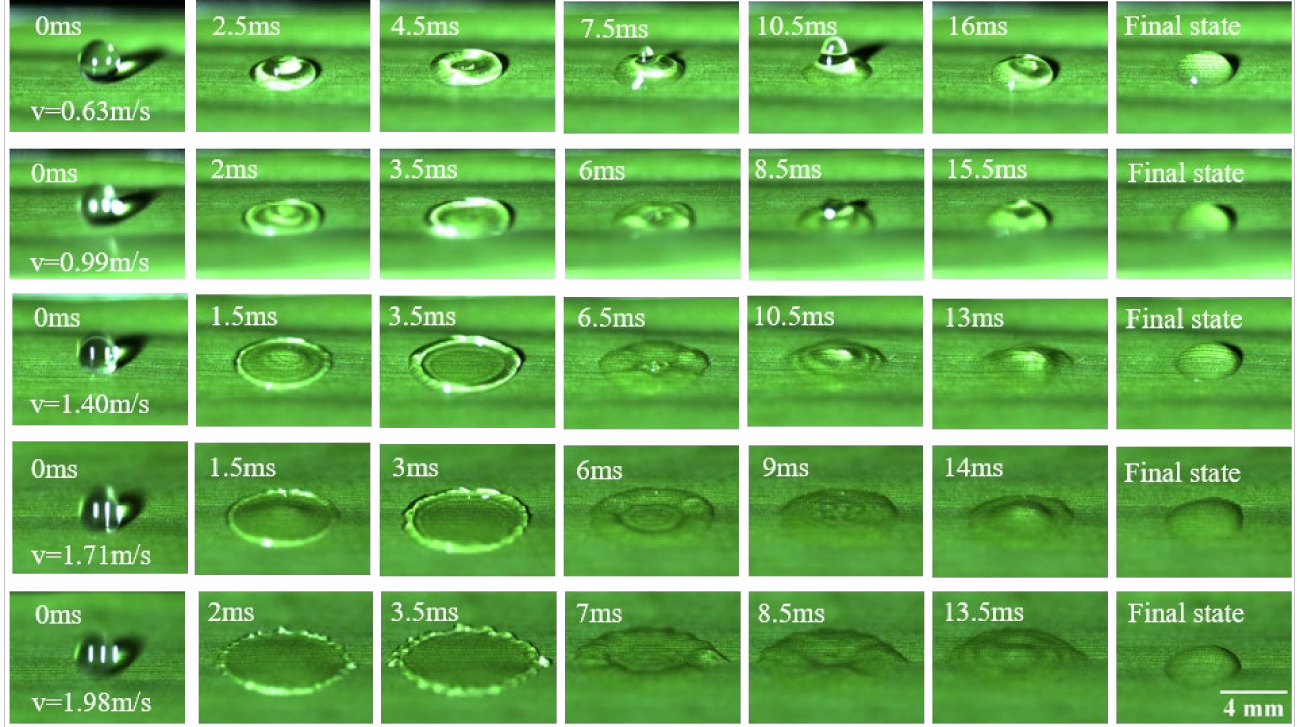
Figure 3. Typical snapshots of droplet impacting at abaxial